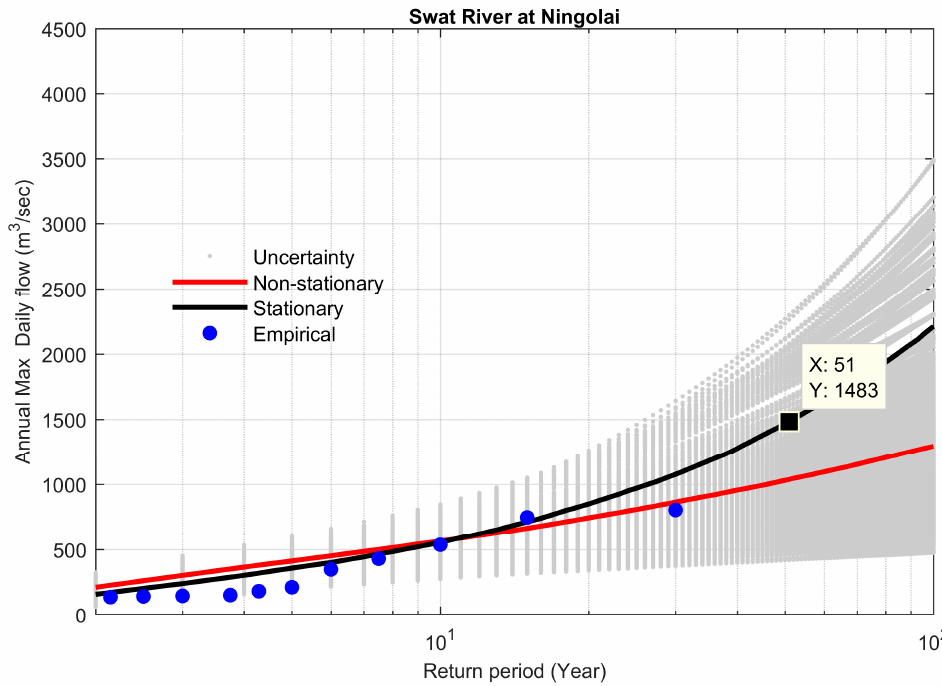
Figure 16. Comparison between non-stationary and stationary FFCs at site 11, along with non-stationary uncertainty bounds for the year 2015.